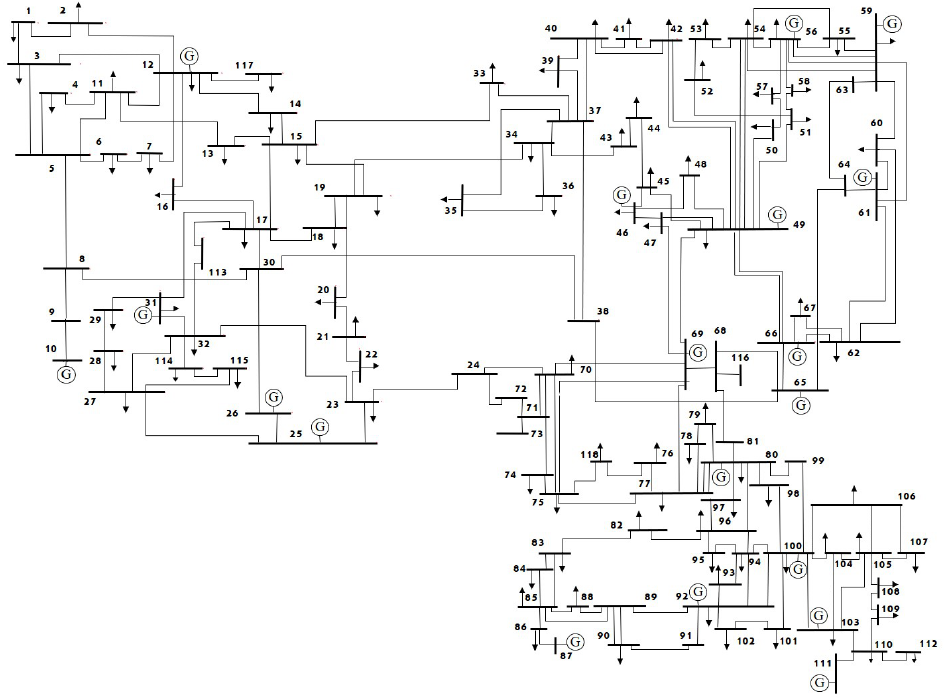
Figure 5. IEEE 118-bus test power system.